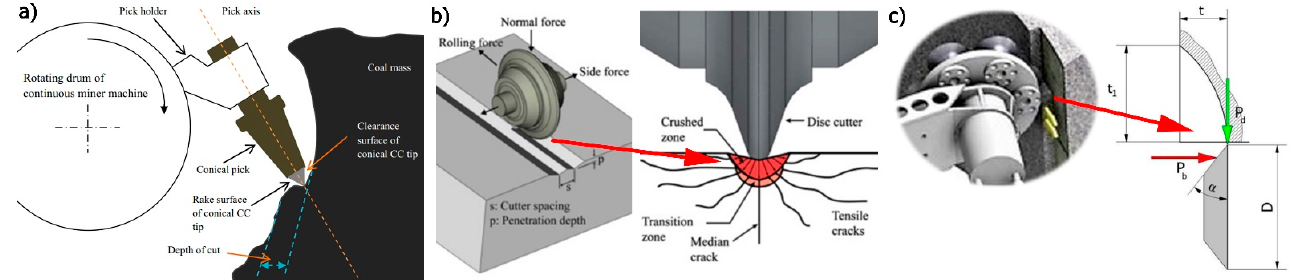
Figure 3. Mining methods based on the use of conical picks and discs: ( a ). cutting [29], ( b ). static pressure [4], and ( c ). undercutting [28] (D—disc diameter, α —disc angle, t 1 —cutting depth, t—cutting spacing, P b —side force, P d —normal force).